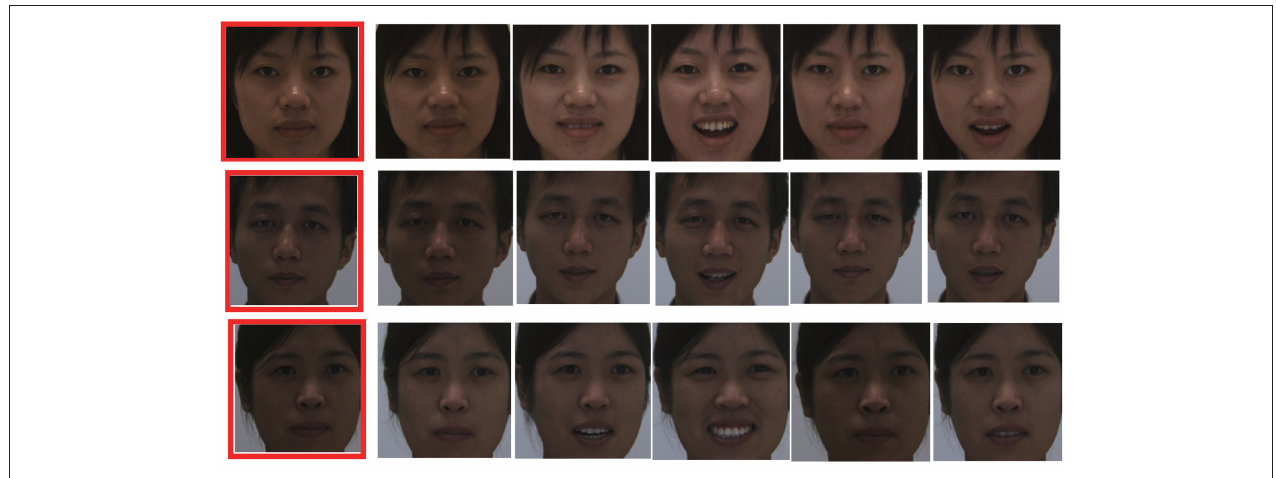
FIGURE 2 | Samples of CASIA-3D Face V1 database. Only one training sample (marked in red) is used for training, the others are used for